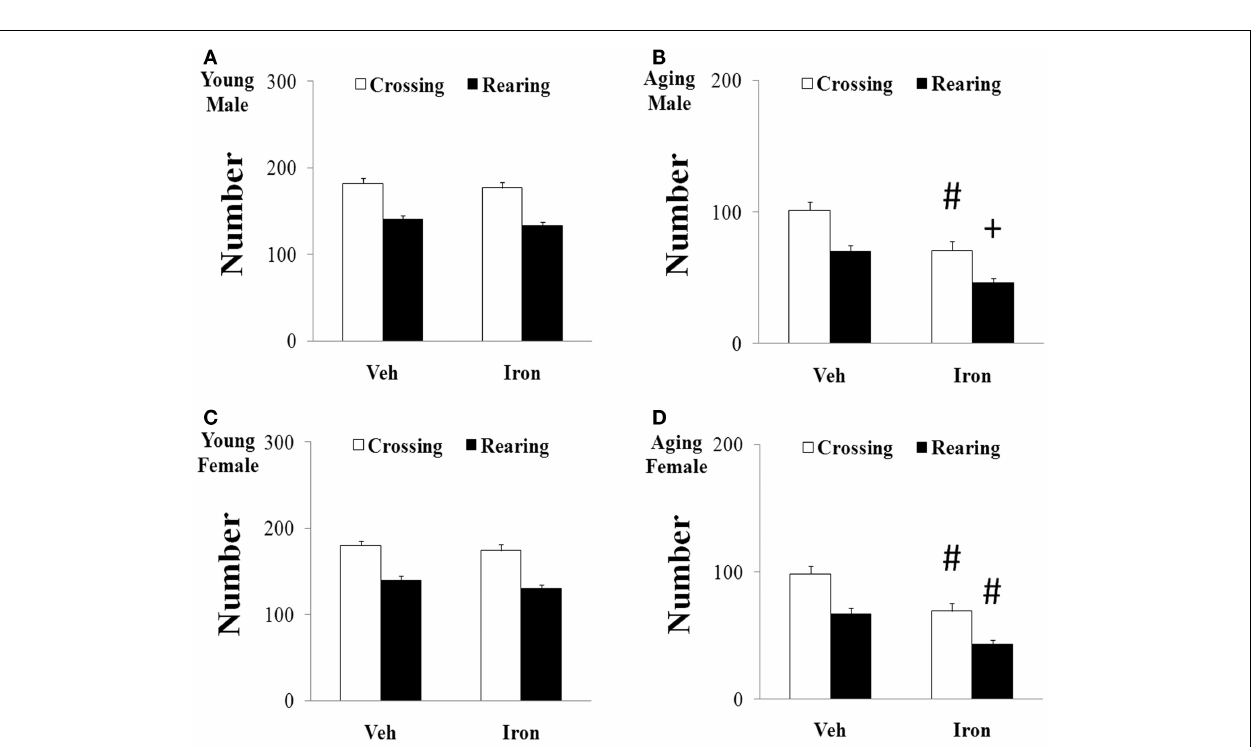
FIGURE 2 | Increased neonatal iron intake resulted in significant behavior abnormality (open-field test) in male (A,B) and female (C,D) rats with aging [(A,C): young; (B,D): aging] . Results are expressed as mean ± SEM. N = 8–10. # p < 0.01, + p < 0.005, compared with the aging rats treated with Veh. Veh, vehicle.